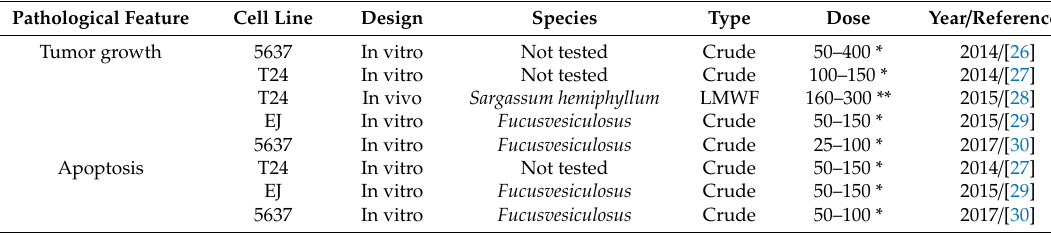
Table 1. Anticancer e ff ects of fucoidans in bladder cancer